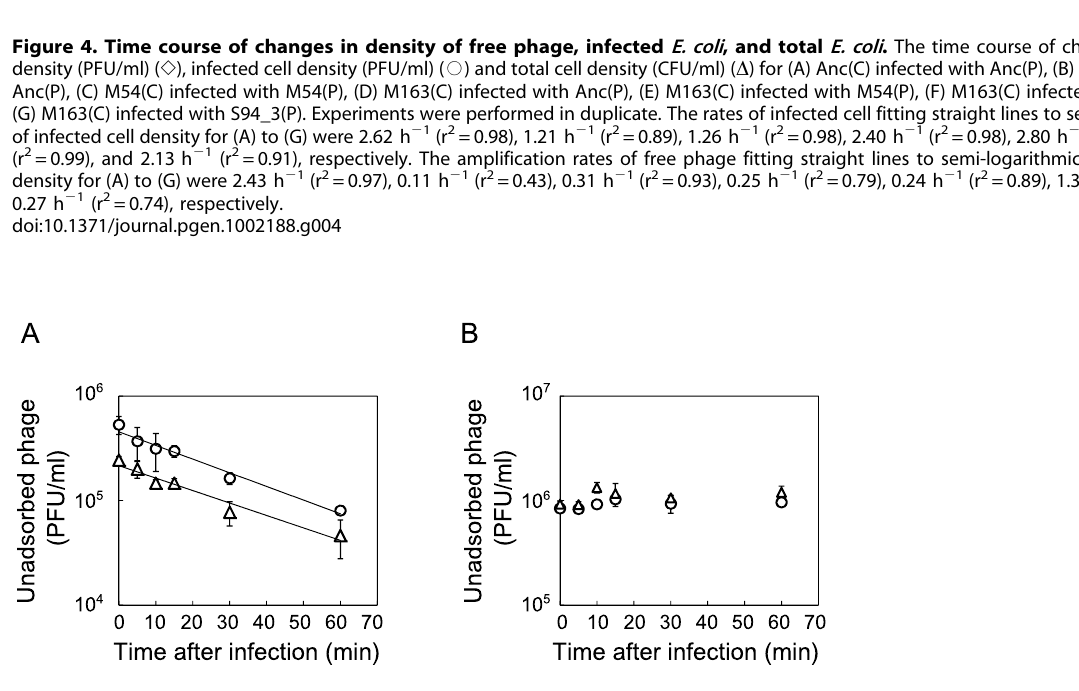
Figure 5. Adsorption rate constants of Anc(P) and M163(P). The concentration of unadsorbed phage was measured as PFU/ml to estimate the Q b phage adsorption rate to Anc(C) or M163(C). (A) Anc(P) ( # ) and M163(P) ( D ) adsorption to Anc(C) were analyzed ( n =3). Values are shown as means 6 SD. The rate constants for adsorption of both Q b to Anc(C) were the same (1.4 6 10 2 9 ml/cells/min) estimated from the slopes of the regression curves. (B) Anc(P) ( # ) and M163(P) ( D ) adsorption to M163(C) were analyzed ( n =3). Values are shown as means 6 SD.